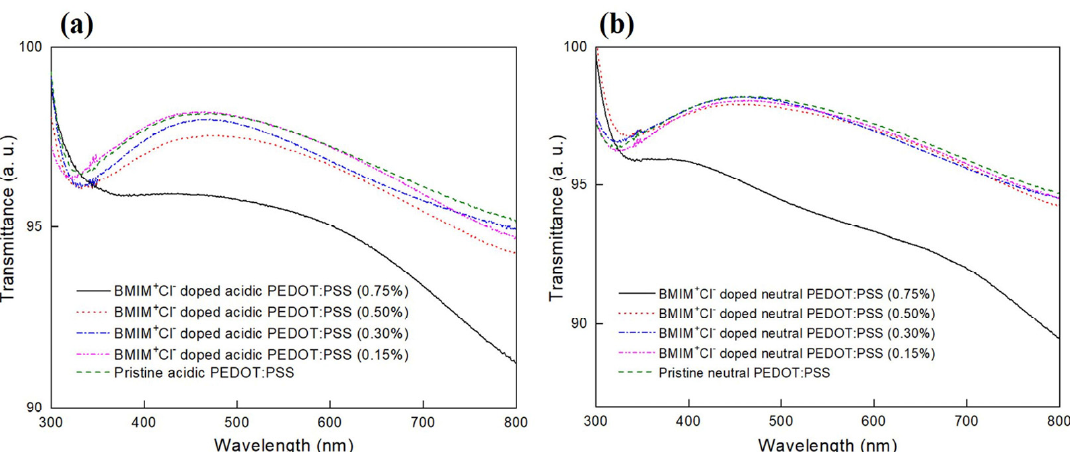
Figure 3. The transmittance spectra of BMIM + Cl − -doped ( a ) acidic PEDOT:PSS and ( b ) pH-neutral PEDOT:PSS films at different concentrations.